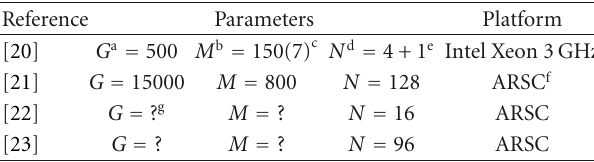
Table 2: Parameter settings in reported work.